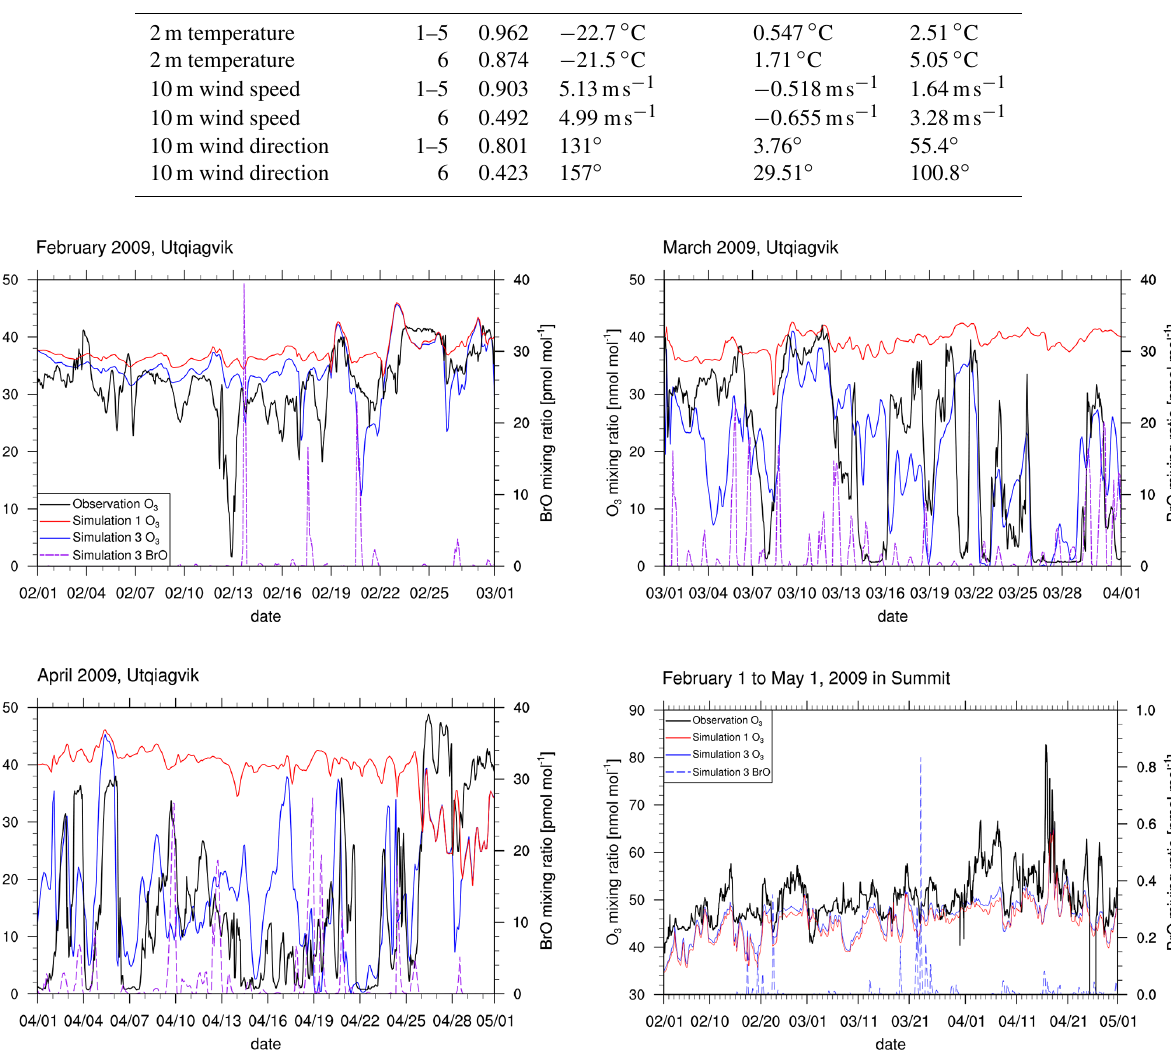
Figure 4. Ozone at Utqia ˙ gvik and at Summit from observations and simulations 1 (no halogens) and 3 (increased emissions, β = 1 . 5). Modeled BrO mixing ratios are also shown. The data are shown at 06:00GMT + 0. The legend is the same for all